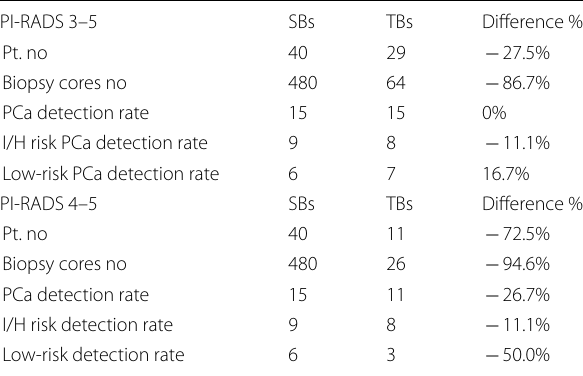
Table 2 Comparison of biopsy outcomes with two different approaches: (a) SBs vs TBs from lesions scored PI‑RADS 3 – 5 and